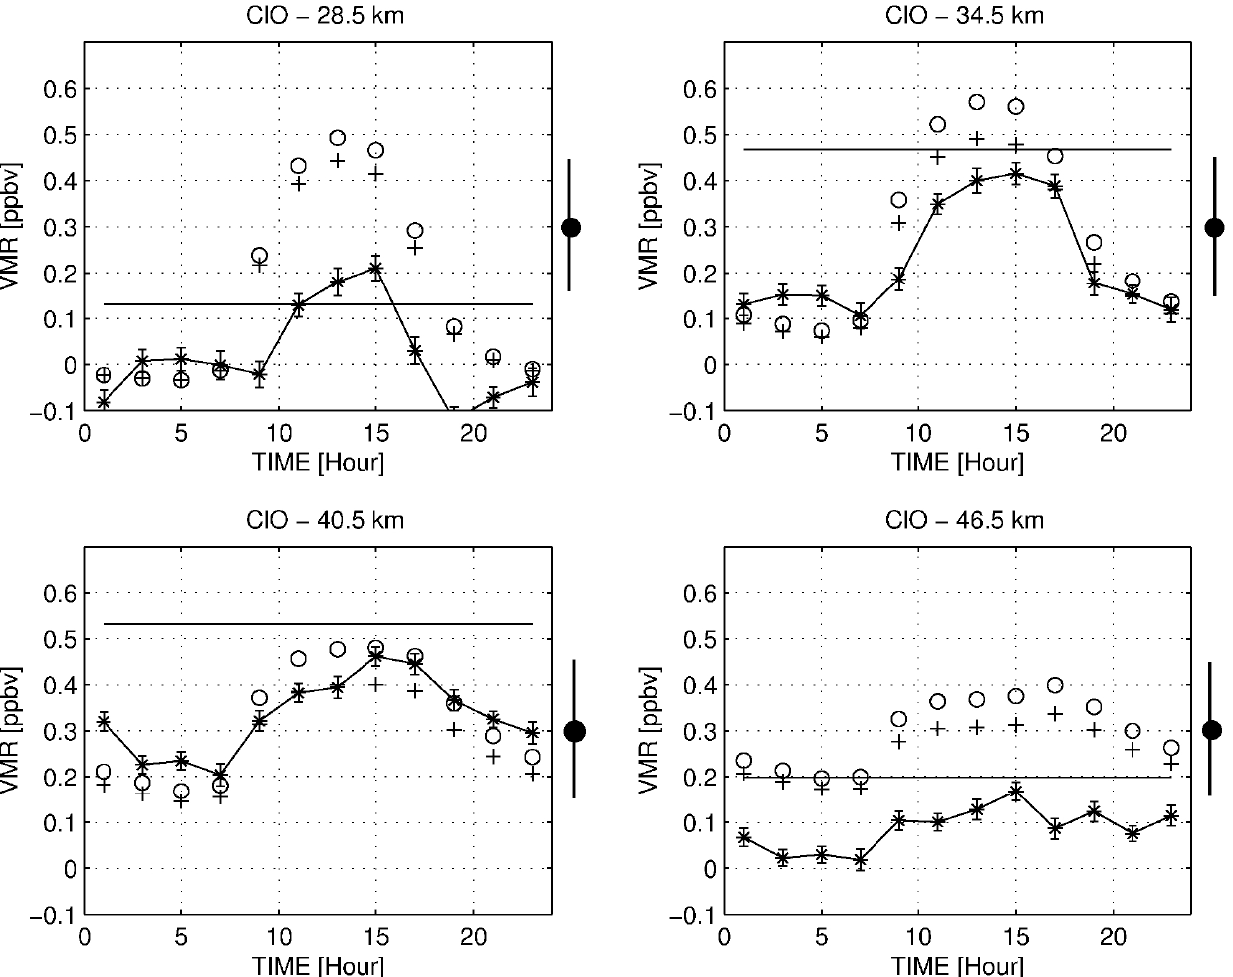
Fig. 15. Measured diurnal variations of ClO (stars) at 28.5, 34.5, 40.5 and 46.5km, together with the a priori value (solid line), and calculations from the 0-D model: run A (crosses) and run B (open circles). Only uncorrelated 1- σ error due to the thermal noise is considered in the errorbar. A systematic 1- σ error for the Bure measurements (filled circle and thick line) is represented on the right-hand side of each